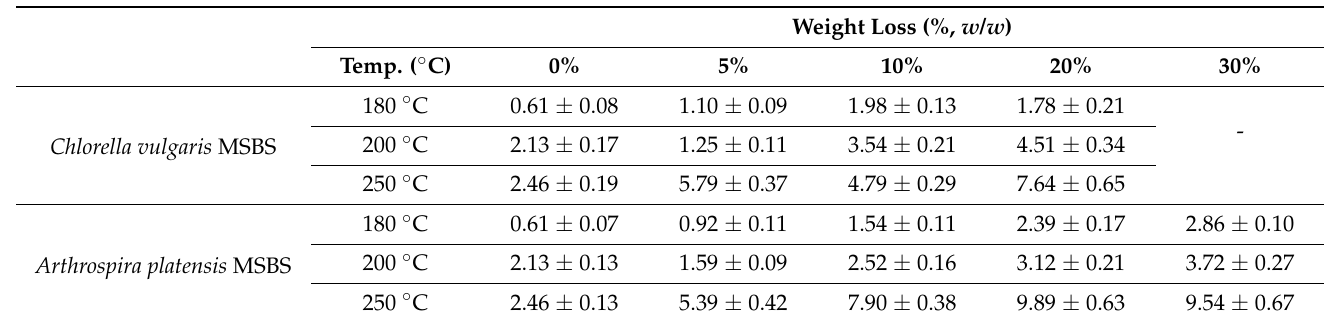
Table 4. Weight loss (%, w / w ) for MSBS dried samples with different levels of biomass content heated for 2 h at 180 ◦ C, 200 ◦ C, and 250 ◦ C.